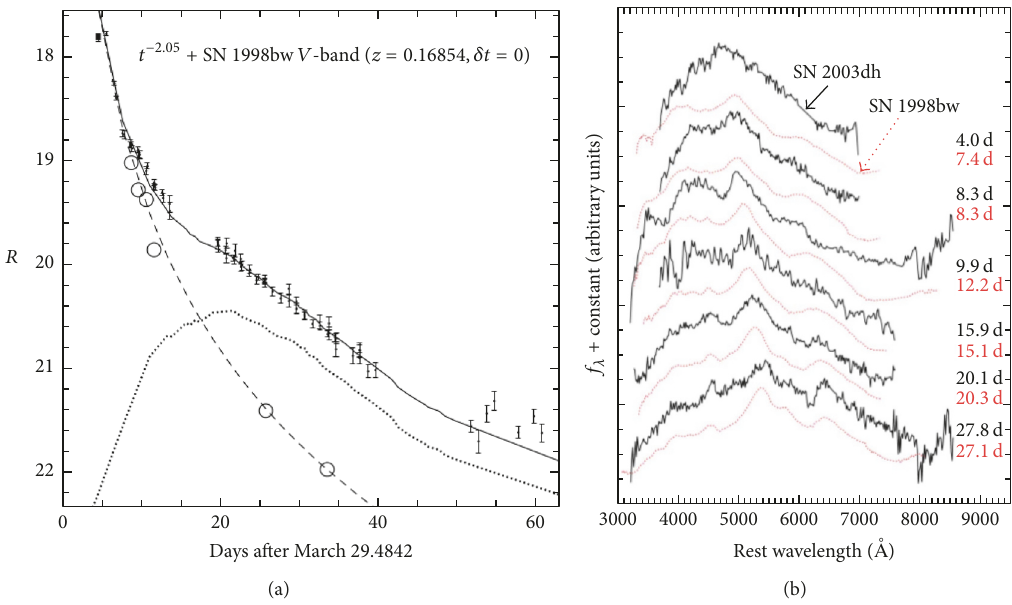
Figure 2: (a) The photometric ( 𝑅 -band) evolution of GRB 030329/SN 2003dh, from [6]; (b) the spectral evolution of GRB 030329/SN 2003dh, as compared with that of SN 1998bw, from